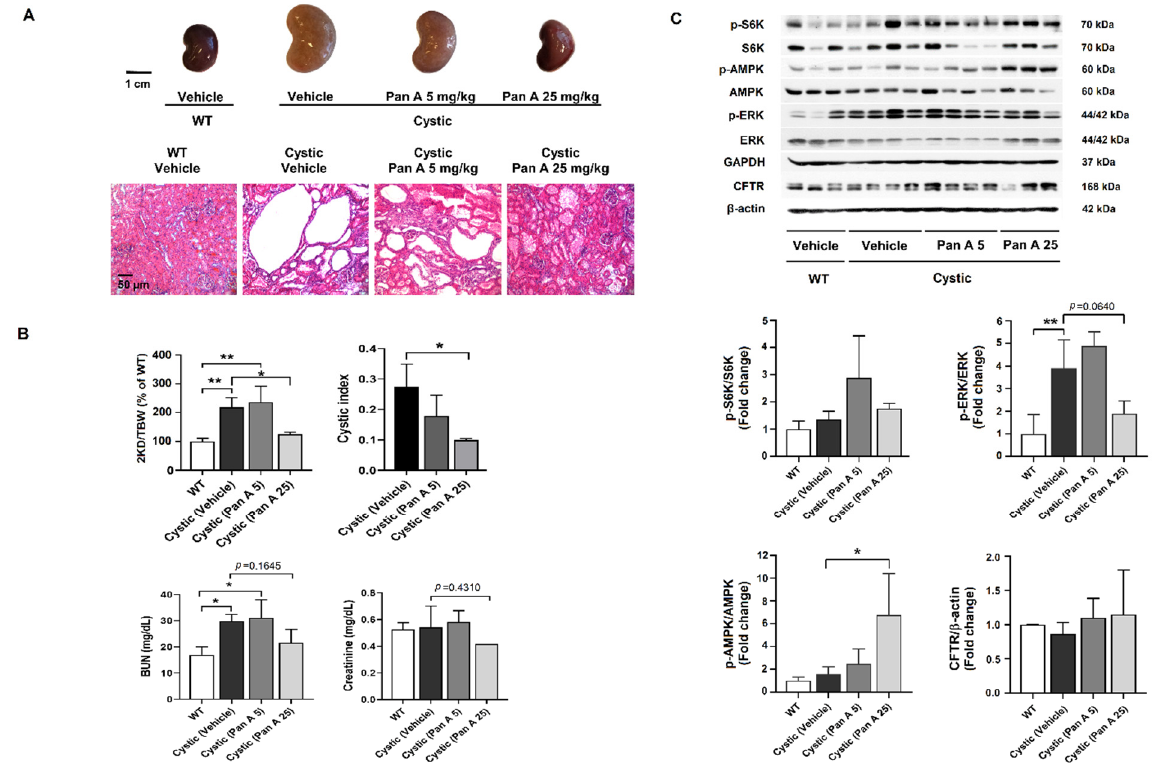
Figure 5. Effect of panduratin A on renal cyst progression in PKD rats. ( A ) Representative images of kidney and H&E staining of histological kidney sections from wild-type (WT), vehicle-treated cystic (Han:SPRD) rats, and panduratin A ((Pan A), 5 mg/kg BW or 25 mg/kg BW)–treated cystic rats. ( B ) Percentage kidney weight to total body weight (2KD/TBW), cystic index, and parameter assessment of renal function in cystic rats. ( C ) Representative immunoblots and band intensities of AMPK, mTOR/S6K, ERK, and CFTR. Data are shown as mean ± SD, n = 3–4 rats per group, * p < 0.05 and ** p < 0.01.